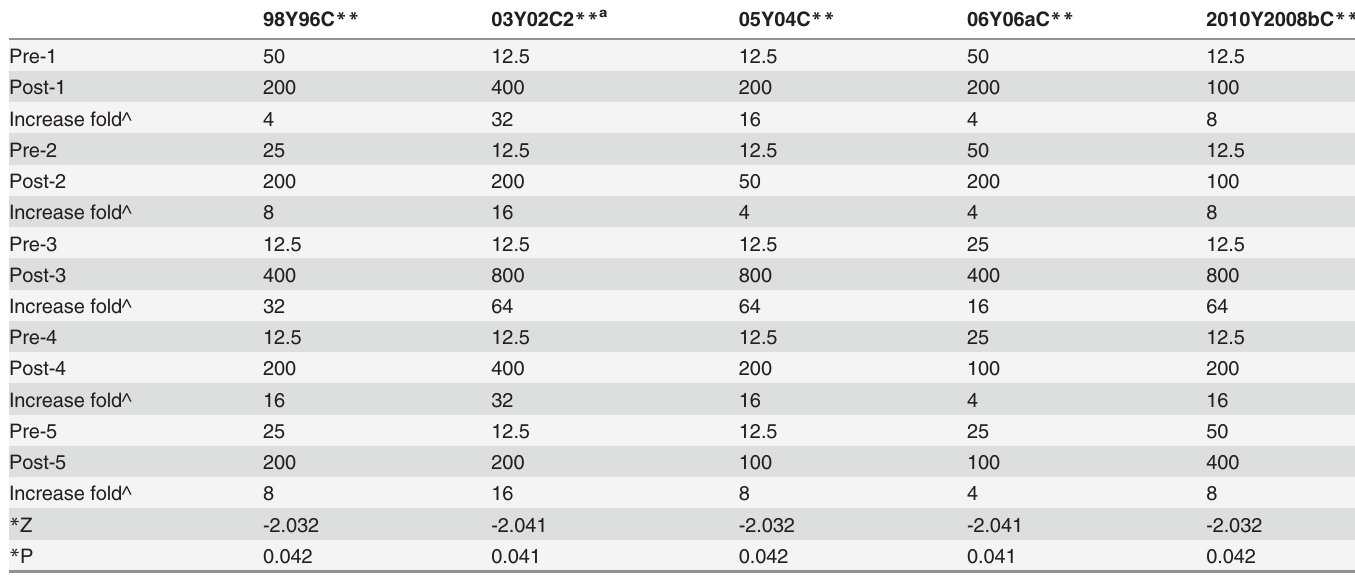
Table 1. HBGA fifty-percent blocking titer of sera antibody and titer increase fold at pre- and post- phase with GII.4 NoV challenge #